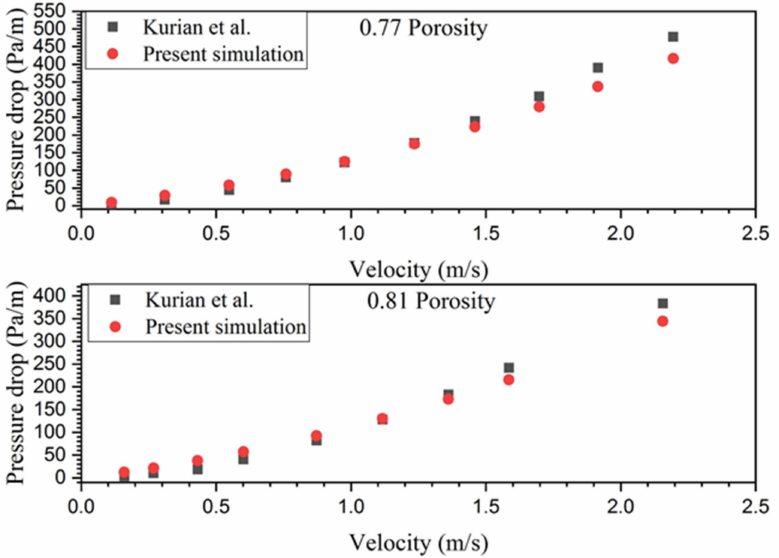
Figure 13. Comparison of pressure drop of present simulations with that of experimental work reported in